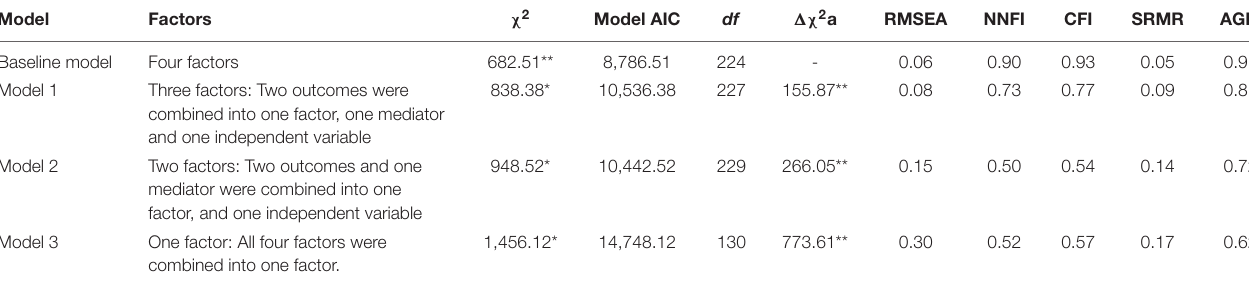
TABLE 1 | Comparison of measurement models.